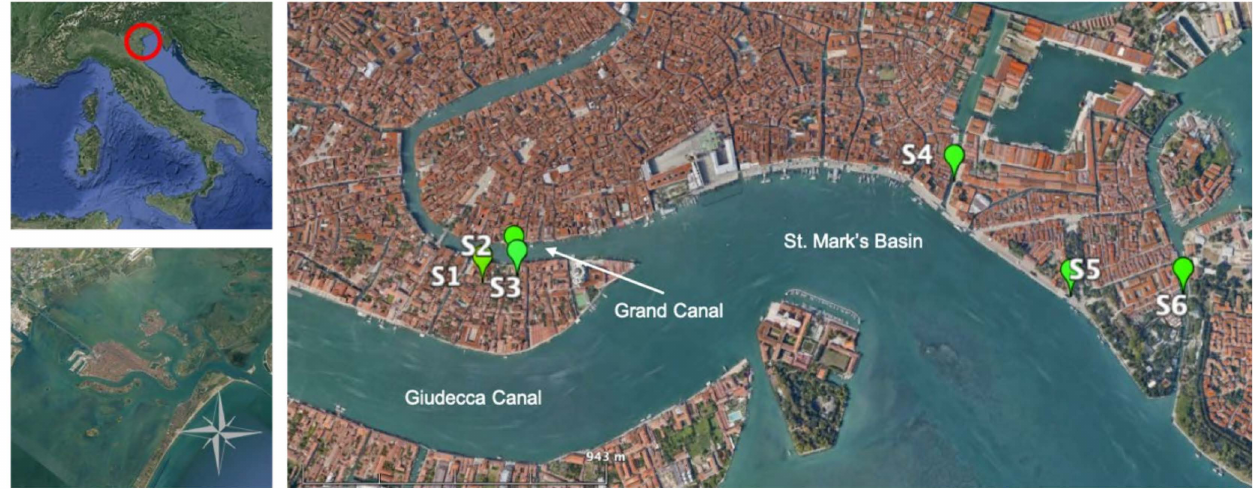
Figure 1. Map showing the study area and the location of the six sampling stations in the canals of the city of